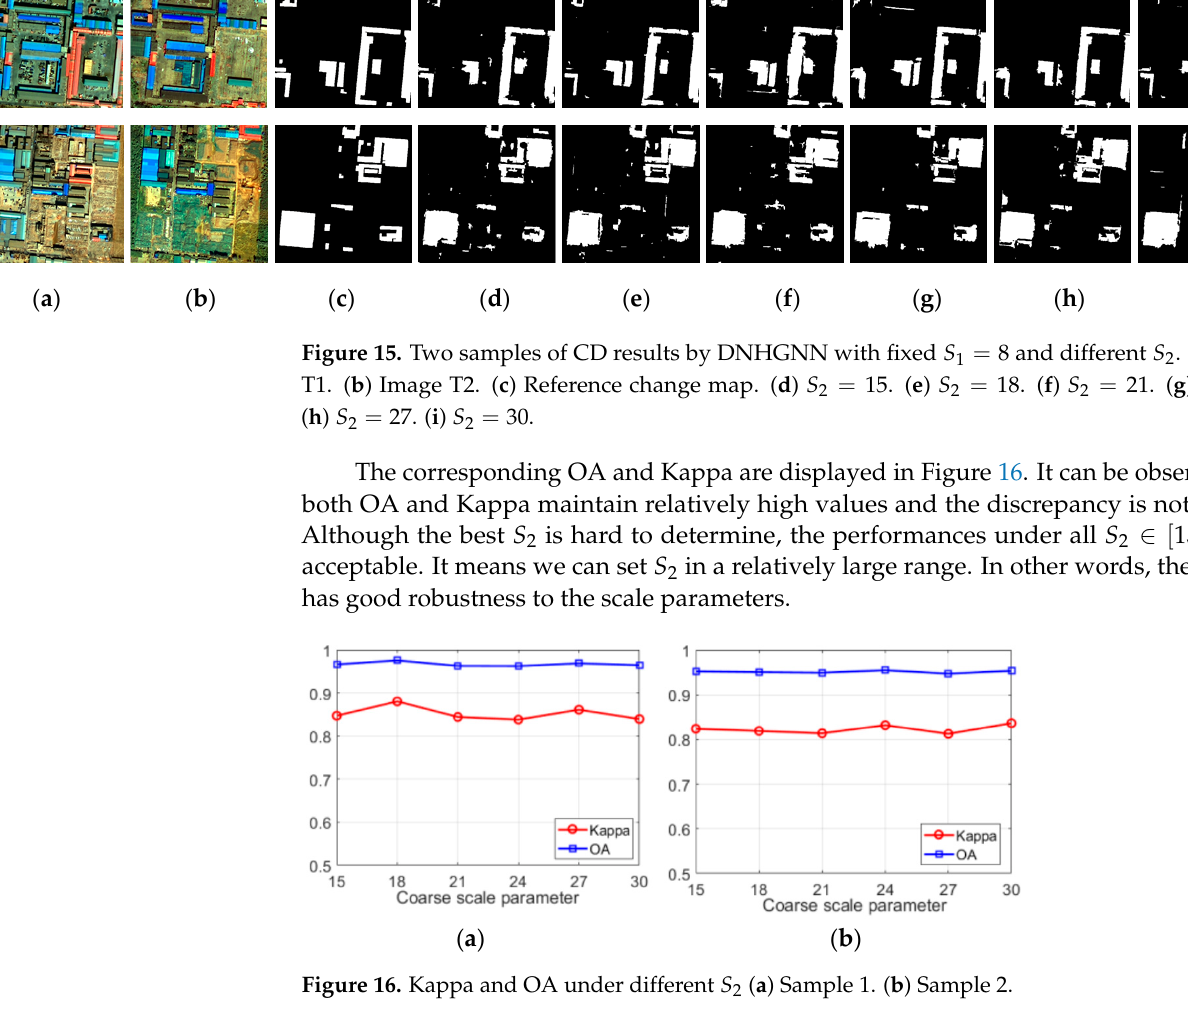
S . ( a ) Sample 1. ( b ) Sample 2. Figure 16. Kappa and OA under different S 2 ( a ) Sample 1. ( b ) Sample 2